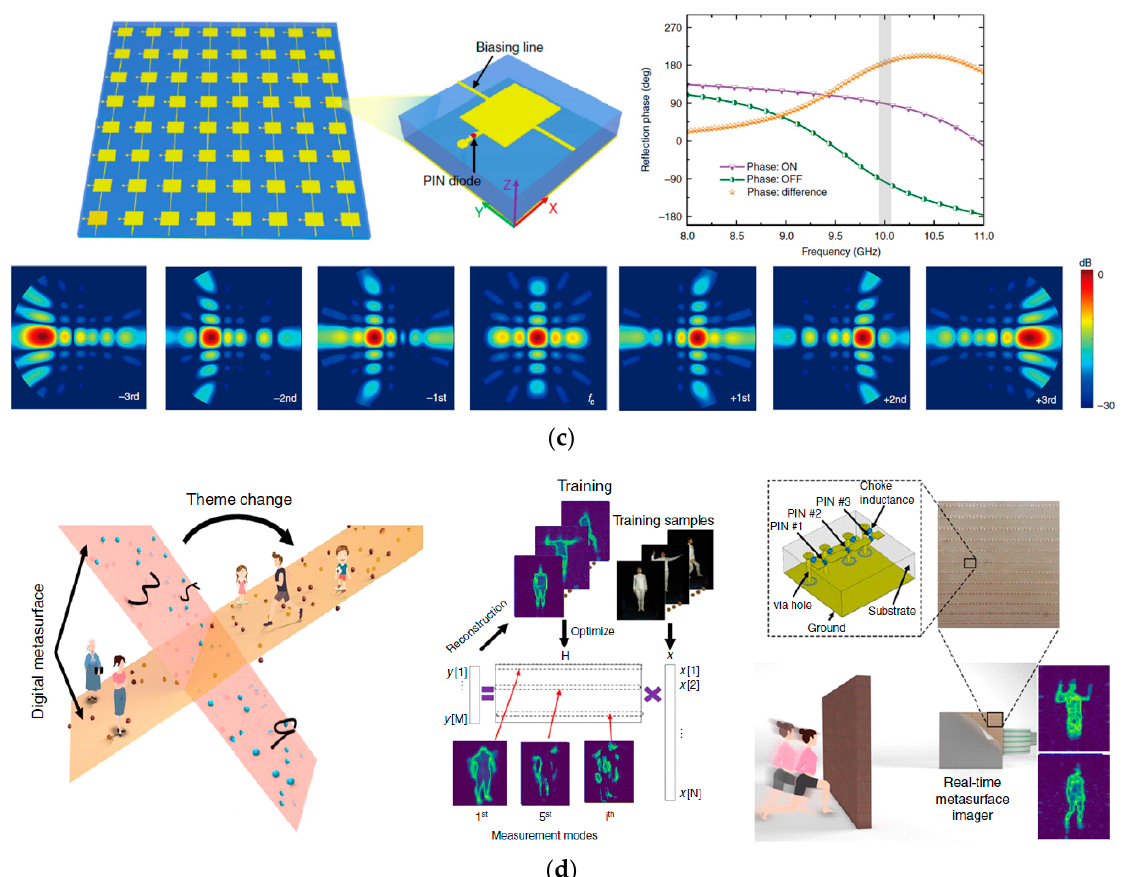
Figure 3. Active and programmable metasurfaces with PIN diodes. ( a ) Amplitude modulation of EIT with PIN diode [52]. ( b ) Ultra − wideband absorber achieving continuous amplitude modulation with PIN diodes [56]. ( c ) Space − time − coded metasurfaces with PIN diodes [36]. The diode can sweep the reflection phase between on and off states and implements the harmonic beam steering. ( d ) Machine − learning reprogrammable metasurface imager with PIN diodes [39].